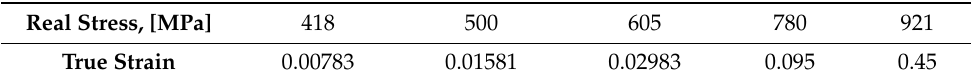
Table 7. SA283D (Strengthened) Real Stress-Strain Parameters.